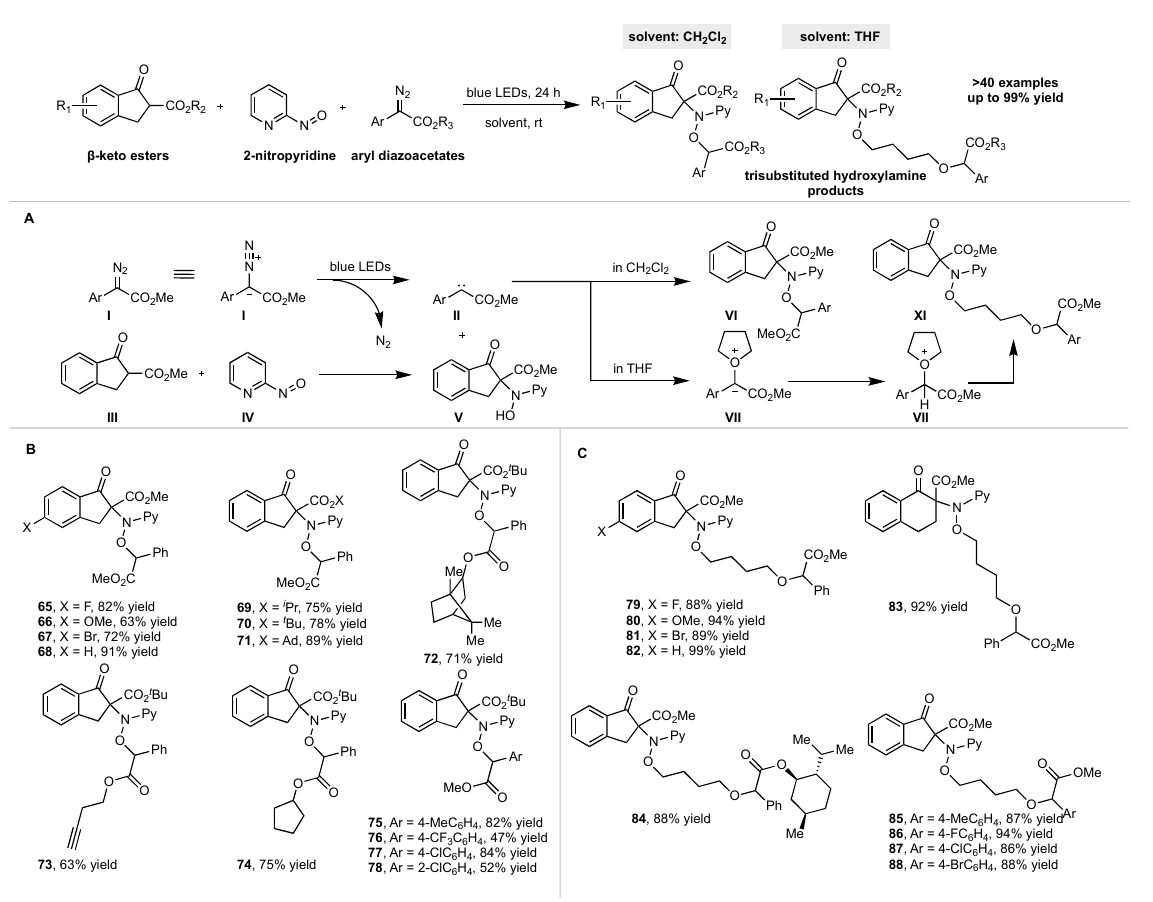
Scheme 7. Zhang, Li, and Xuan(cid:31)s multicomponent synthesis of trisubstituted hydroxylamines. ( A ) Selected examples of the transformation using CH 2 Cl 2 as solvent. ( B ) Selected examples of the reac- tion using THF as solvent. ( C ) Proposed mechanism to account for di ff erential reactivity in